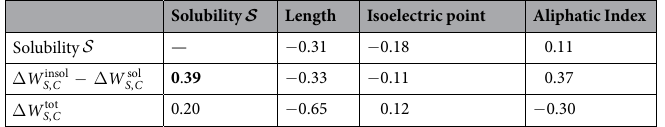
Table 3. Correlation between experimental solubility, folding free energies and sequence-derived